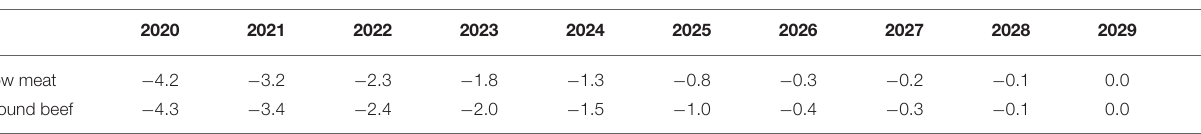
TABLE 4 | Scenario results.